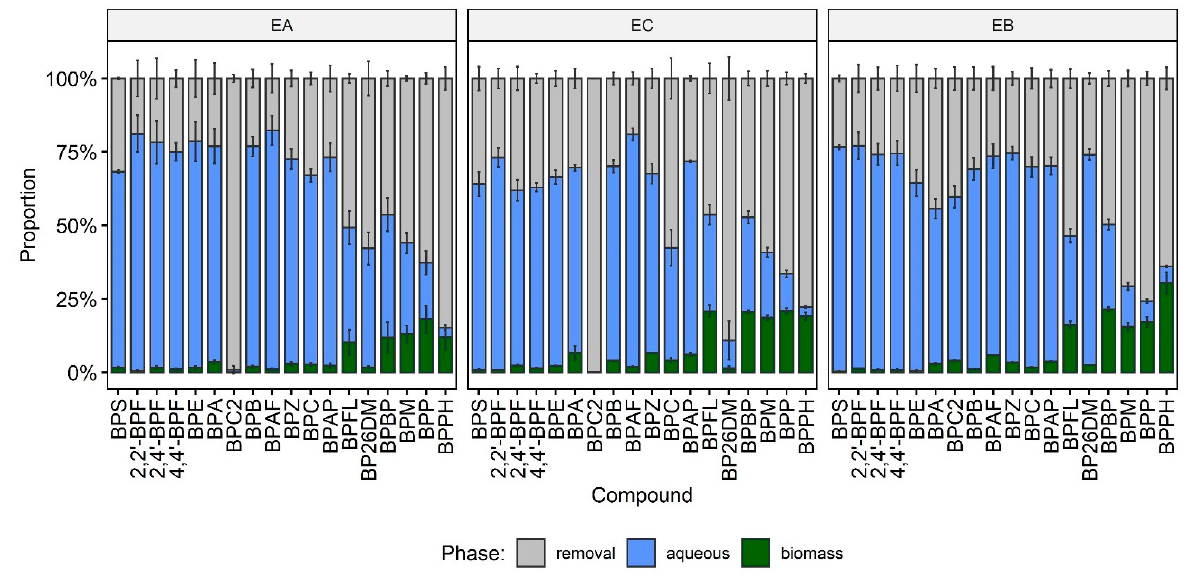
Figure 5. Proportion of BPs in axenic microalgae (EA), co-cultures (EC) and bacterial cultures (EB) 168 h after addition of BPs to the medium ( n = 3 for each group). The proportions of the aqueous phase, biomass phase and calculated removal are shown with mean ± standard deviation. Compounds are arranged from lowest (BPS, log P = 2.3) to highest (BPPH, log P = 7.3) log P value. Biotic removal (total removal—ABL, Figure 6) ranged from 0% (BP26DM, BPPH, BPFL and BPAF) to 71 ± 0.1% (BPC2 in co-culture). Statistically significant differences ( p ≤ 0.05) between the three cultures were found for BPS, BPA, BPC2, BPC, BP26DM, BPM, BPP and BPPH. In the axenic/mixed cultures, microalgae removed more than 70% of BPC2 whereas bacteria removed less than 20% (Figure 6). In contrast, the differences in removal of BPPH between all three cultures were small (Figure 6) and followed the amount of biomass (Figure 5). In the case of BPS, BPC and BP26DM, the co-culture proved the most efficient; however, for BPS, the removal in all three cultures was lower than 20%. The highest removals were detected for BPC2 in the microalgal culture (71 ± 1%) and co-culture (71 ± 0.1%). The removals of BPA (22 ± 3%), BPM (28 ± 3%) and BPP (24 ± 2%) were higher in the bacterial culture than in the algal cultures.